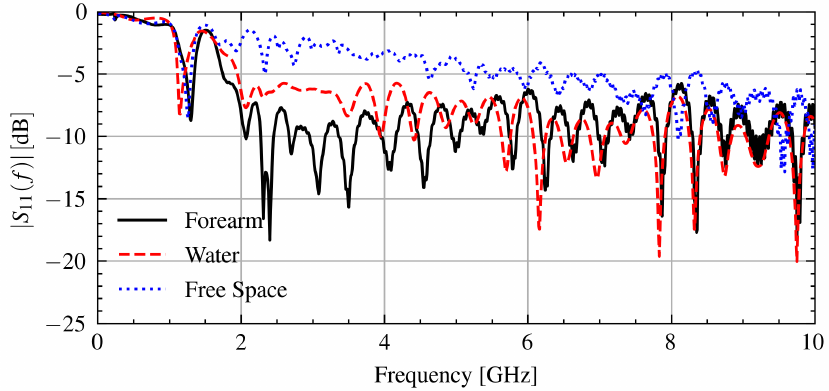
Figure 6. Measured S 11 ( f ) signals when in contact with a forearm, water, and free space.